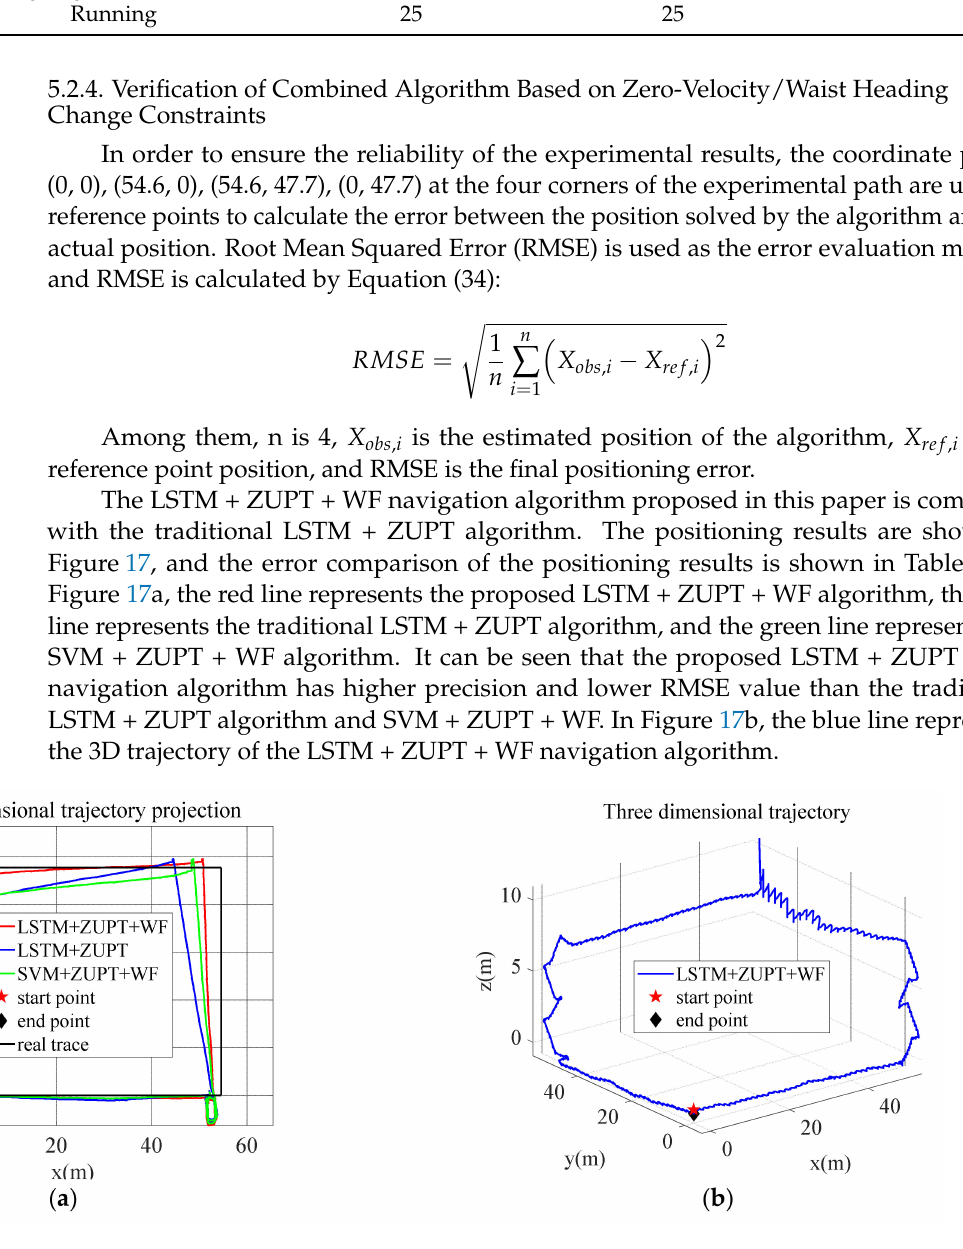
Figure 17. Pedestrian experimental trajectory: ( a ) two-dimensional trajectory projection; and ( b ) three- dimensional